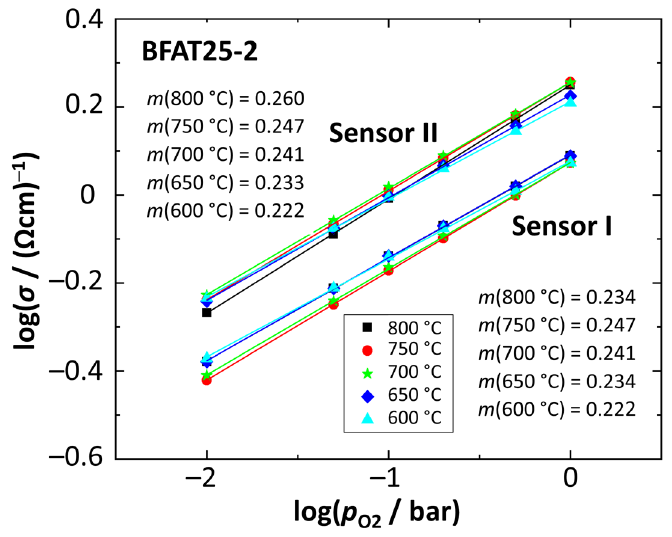
Figure 6. Oxygen sensitivity of the BFAT25 fi lm with the calculated slope m . Table 2. Oxygen sensitivities m of the BFAT25 fi lms.